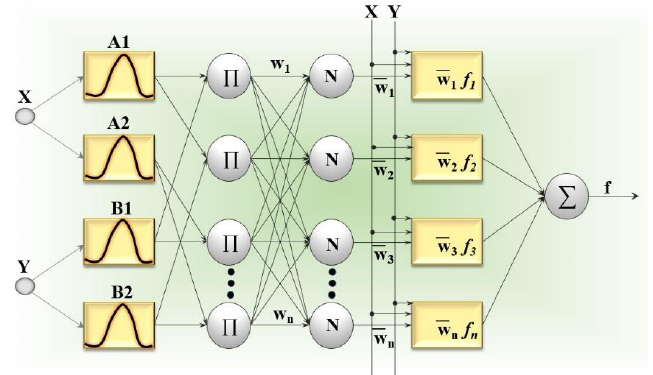
Figure 16. The structure of adaptive network based fuzzy inference system.